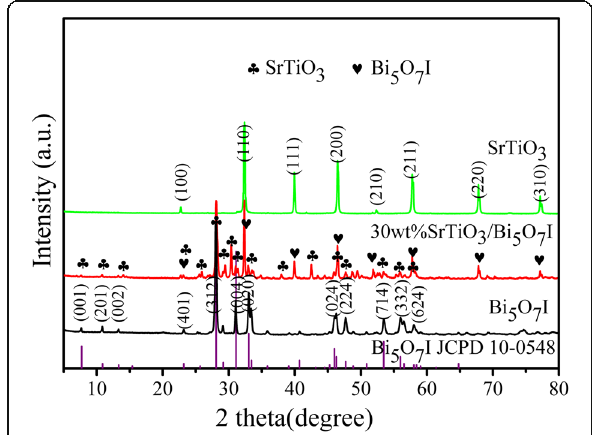
Fig. 1 XRD patterns of pure Bi 5 O 7 I, SrTiO 3 and 30 wt% SrTiO